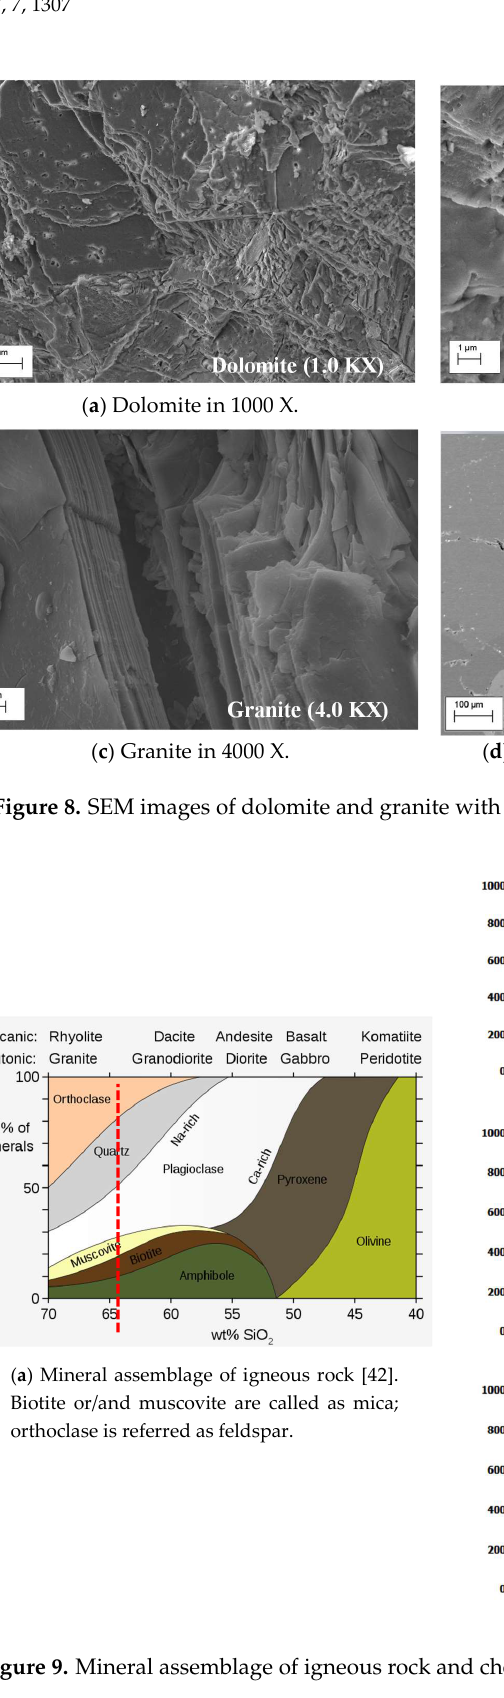
Figure 9. Mineral assemblage of igneous rock and chemical compositional analysis results.